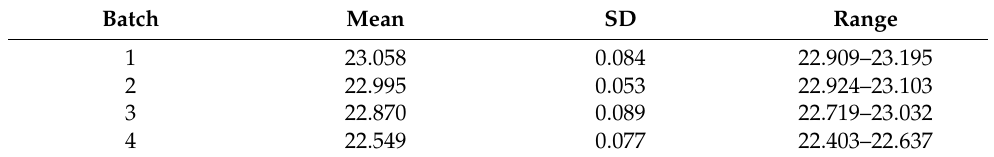
Table 2. Specific density ( σ t ) of fertilized walleye pollock eggs (<1 day post fertilization; n = 20). For comparison, the density of the coastal Oyashio water mass is 26.4 ( σ t ). Batch Mean